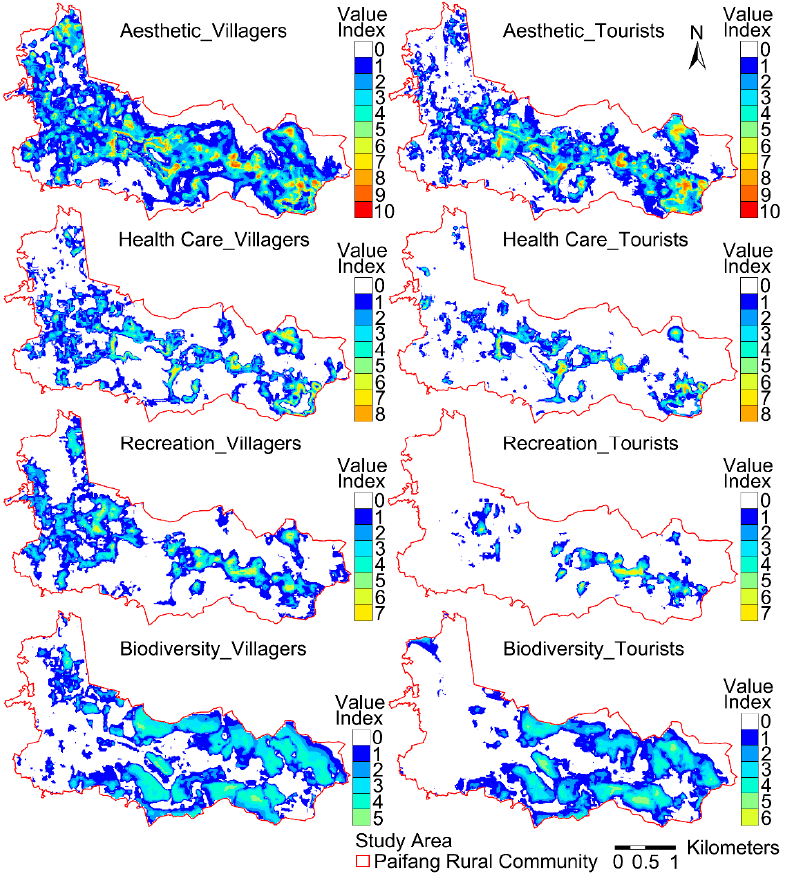
Figure 9. Differences in the perception of the spatial distribution of social values among the villagers and tourists in the Paifang rural community. Table 6. Correlation analysis of social values between villagers and